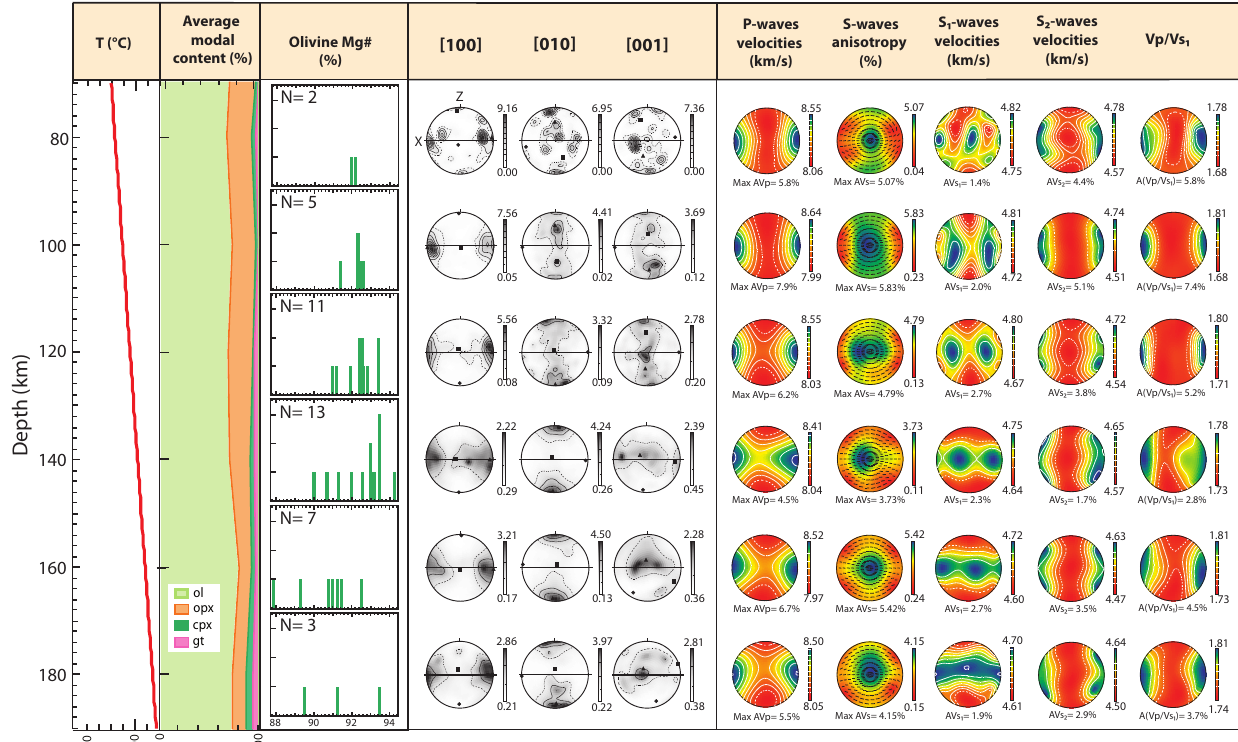
Fig. 6. Mean compositions, CPOs and seismic properties of five 20-km sections between 70 and 190km depth calculated by averaging the olivine composition and modal contents of the samples originated from these depths. From left to right, are displayed: the geotherm of Baptiste et al. (2012), the average modal content of the samples, the number and the olivine Mg# of the samples in each depth section, the average olivine crystal-preferred orientations, and the 3-D distributions of P wave velocities ( V p ), S wave polarization anisotropy ( V s ), the orientation of the fast shear wave polarization plane, S 1 wave velocities ( V S